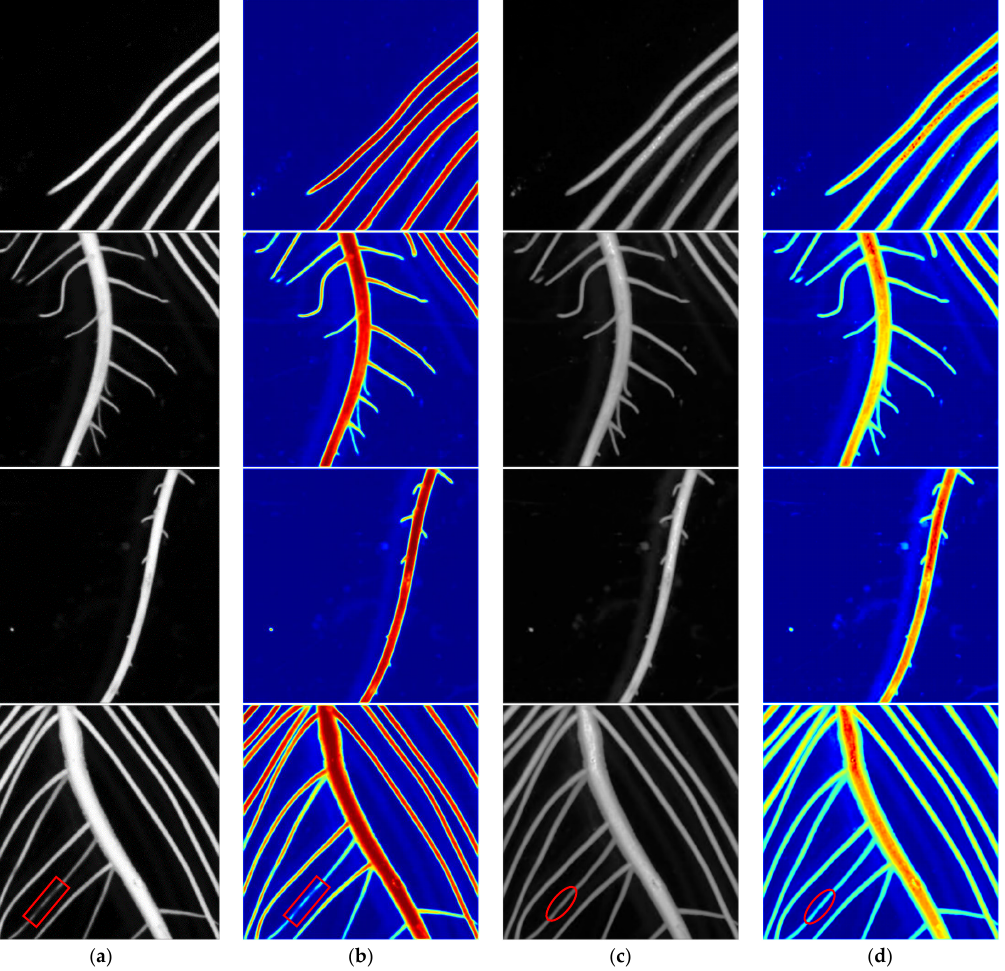
Figure 11. Visualization results of feature maps and heat maps on different models. ( a ) U-Net feature map; ( b ) U-Net heat map; ( c ) Improved U-Net feature map; ( d ) Improved U-Net heat map.